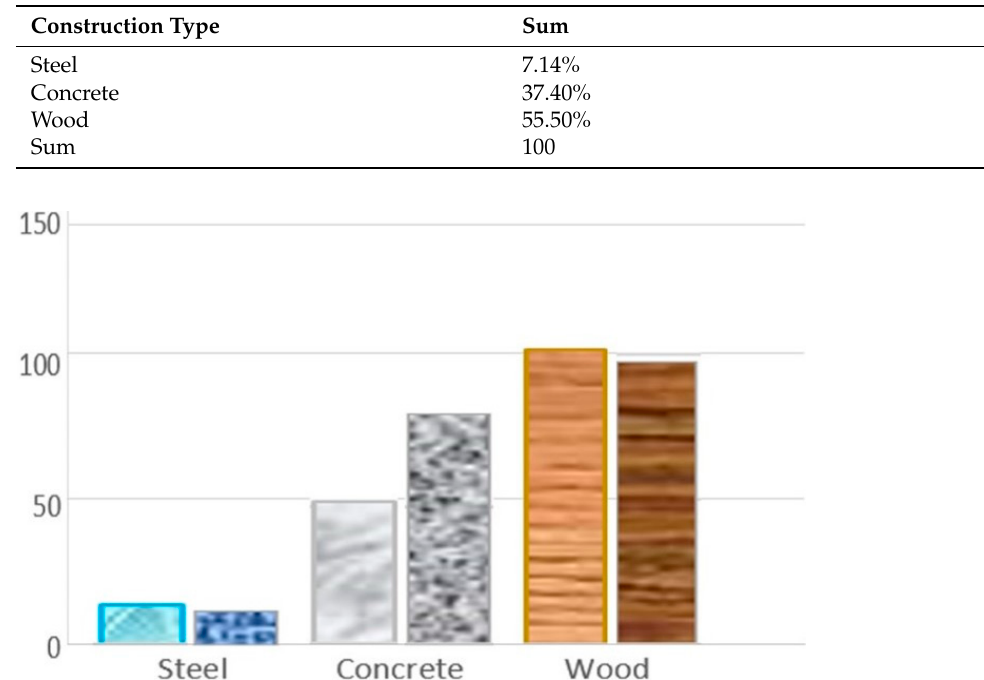
Table 7. Percentage of level of social trends towards CMs (i.e., with 500 participants).